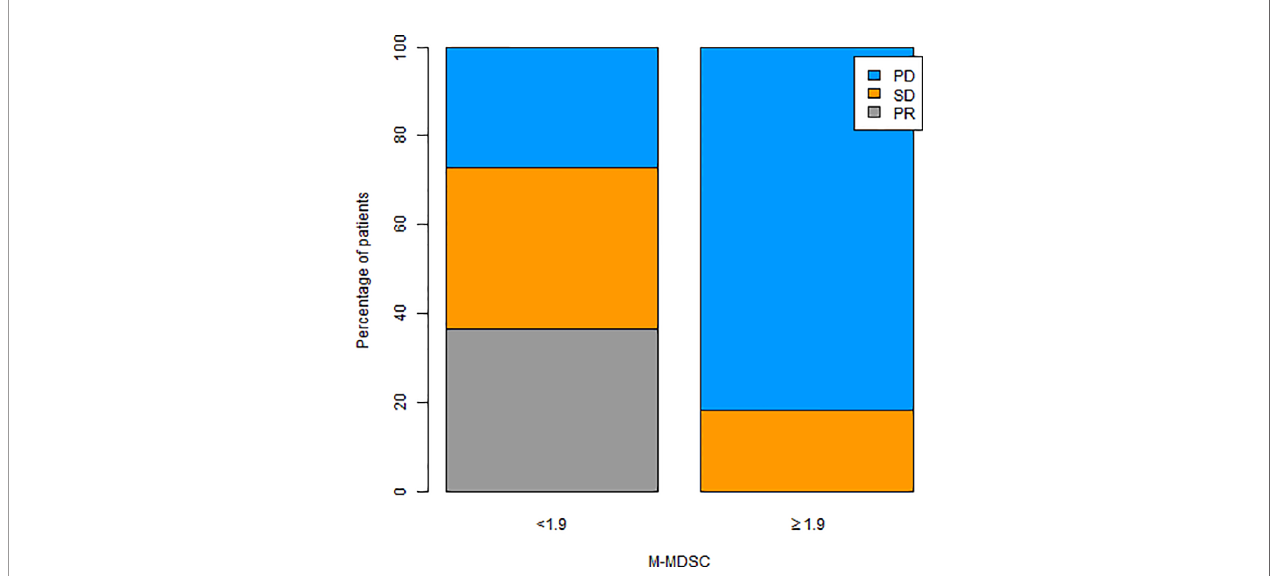
FIGURE 2 | Tumor response according to M-MDSC levels (< vs. > median value). M-MDSC, monocytic myeloid-derived suppressive-like cell.